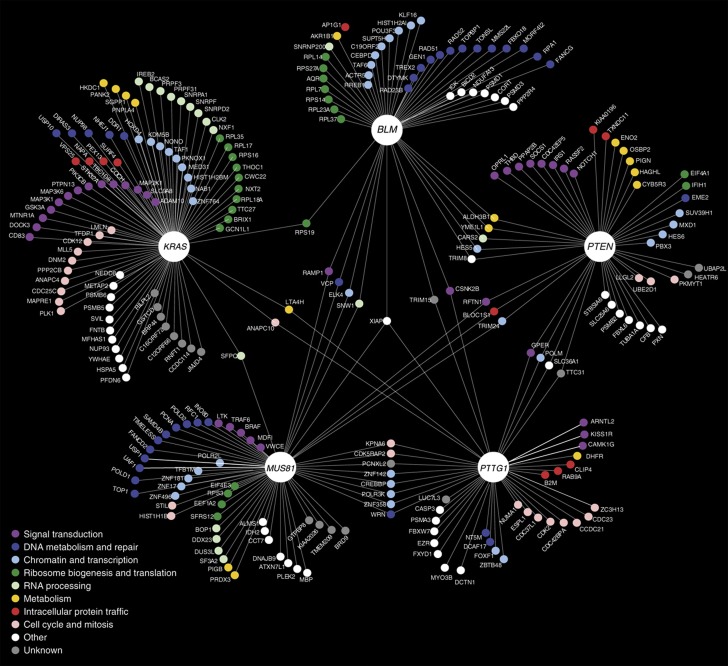
Differential essentiality or DiE map. High-confidence network of confirmed and/or conserved negative genetic interactions represented as edges connected to one or more of the five query genotypes described in the text, including KRAS, PTTG1, PTEN, MUS81 and BLM. Genes are represented as nodes and these are color coded according to the biological functions indicated in the legend.